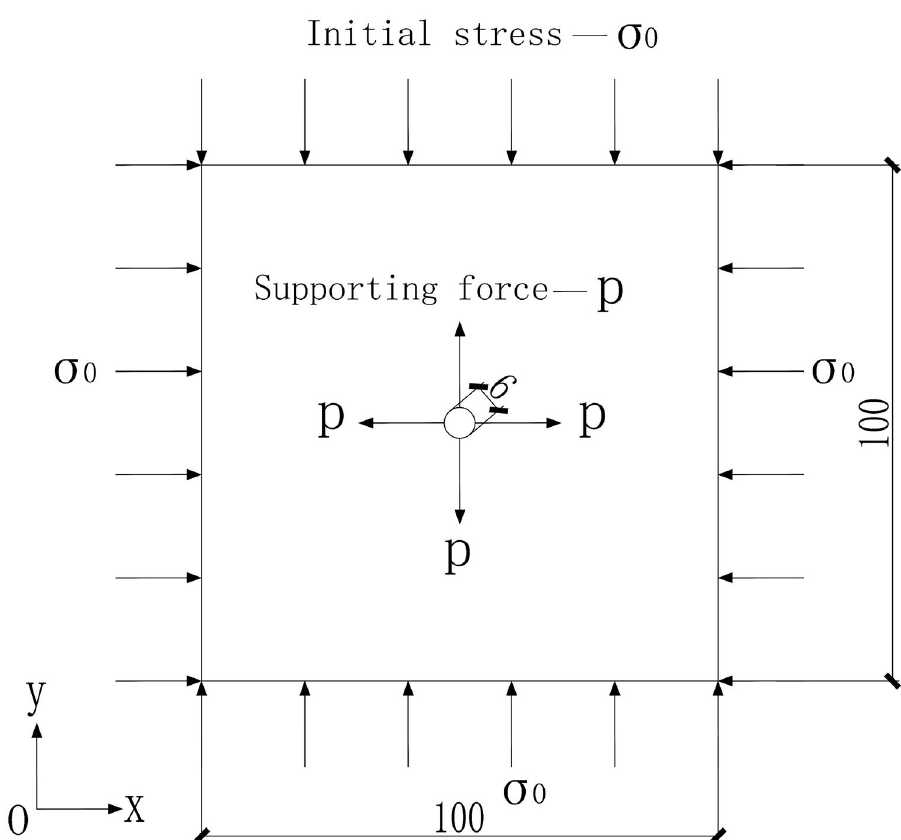
Fig 4. A section of deep-buried elastic circular tunnel.